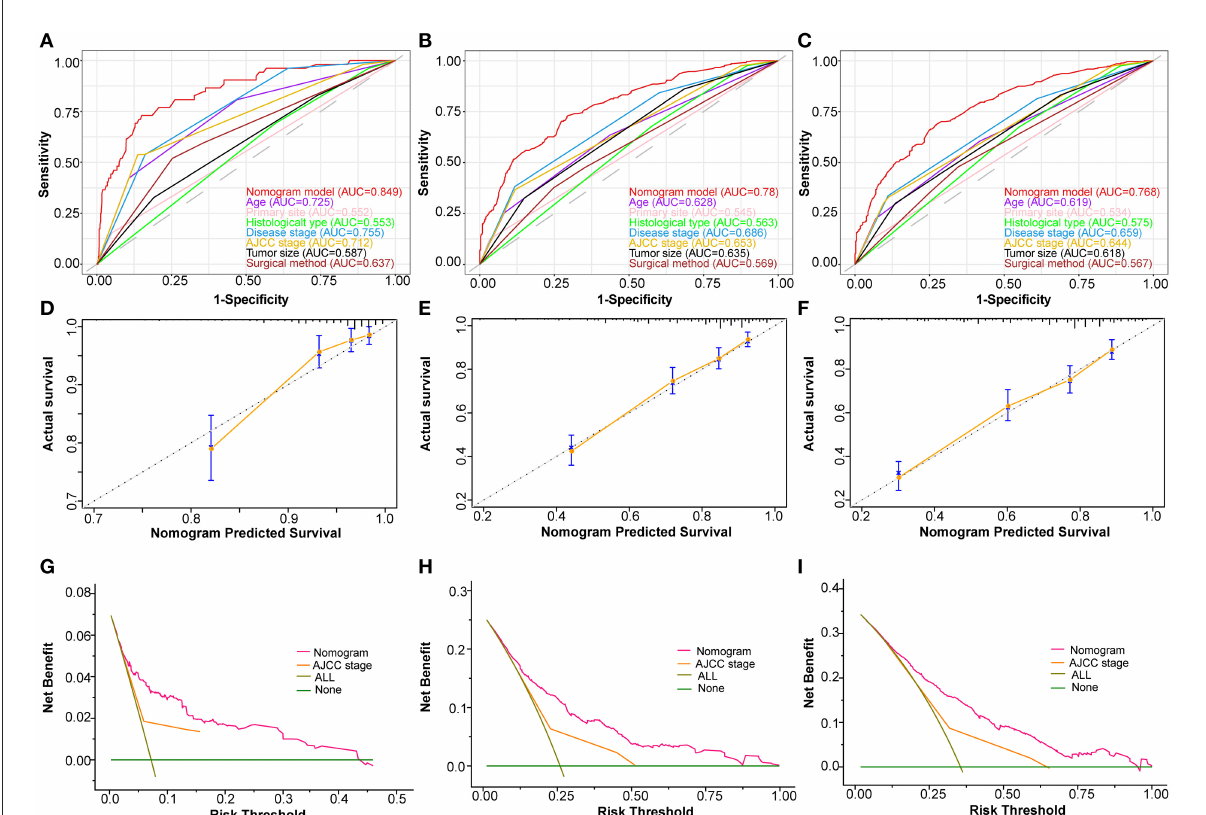
FIGURE3 Validating the prognostic nomogram in the training cohort. Receiver operating characteristic curves (ROC) for 1 (A) , 3 (B) , and 5 (C) years in the training cohort, comparing the predictive ability between the nomogram and all independent factors, including age, primary site, histological type, disease stage, AJCC Stage, tumor size, and surgery. The calibration curves of the nomogram for 1 (D) , 2 (E) , and 3 (F) years in the training cohort. The decision curve analysis of the nomogram for 1 (G) , 2 (H) , and 3 (I) years in the training cohort, comparing the predictive ability of the nomogram with the AJCC